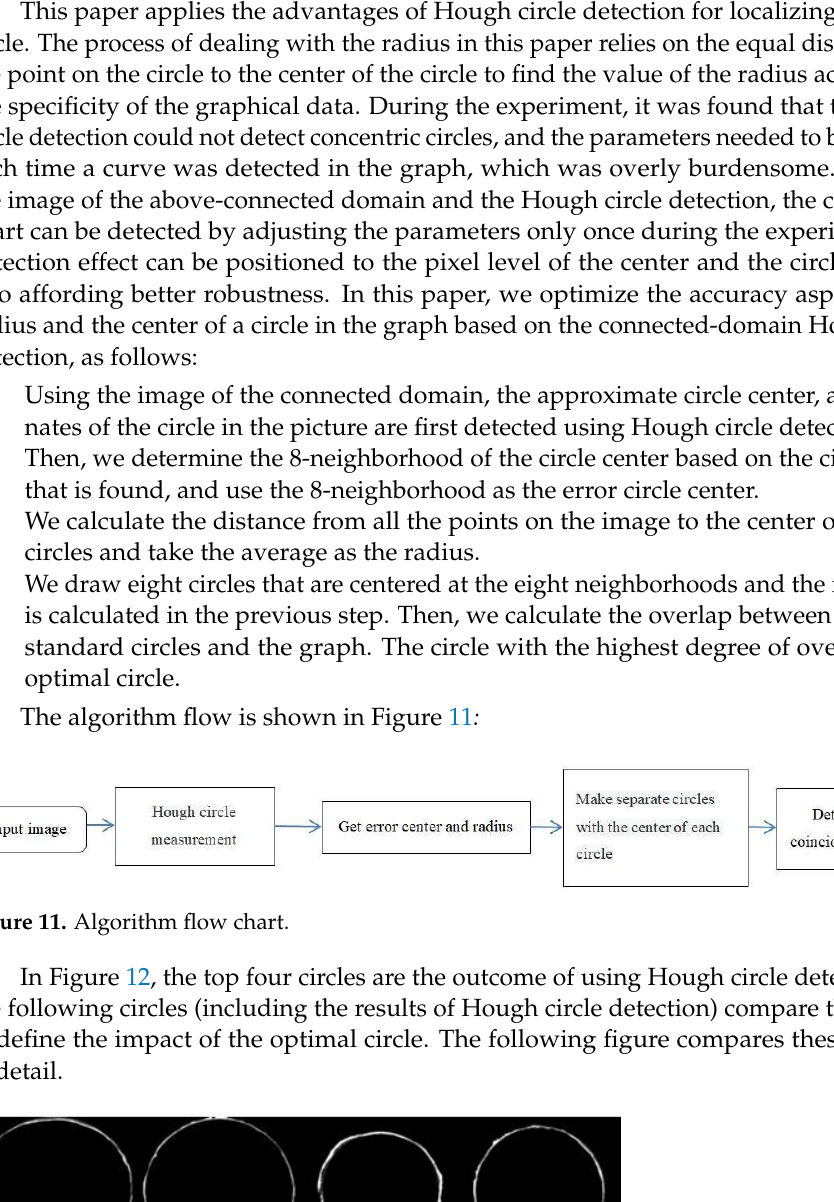
Figure 13. Detail comparison. Table 2. Pixel consistency comparison. Outer Circle1 Inner Circle1 Outer Circle 2 Inner Circle2 Hough Round overlap